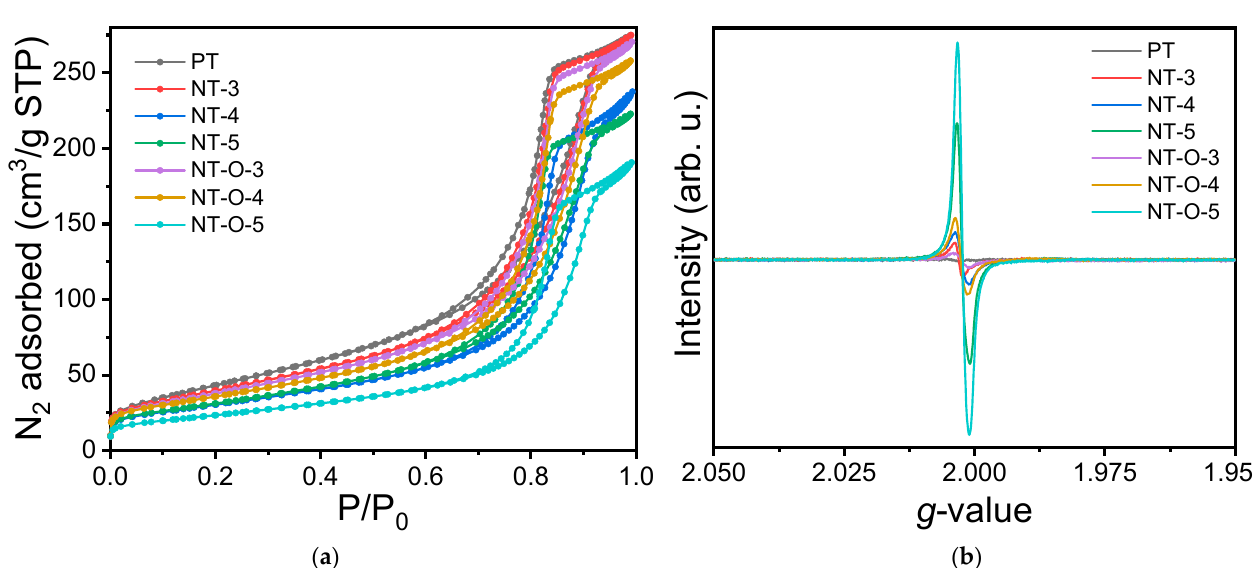
Figure 4. ( a ) N 2 adsorption/desorption isotherms and ( b ) EPR spectra of TiO 2 samples collected at room temperature.